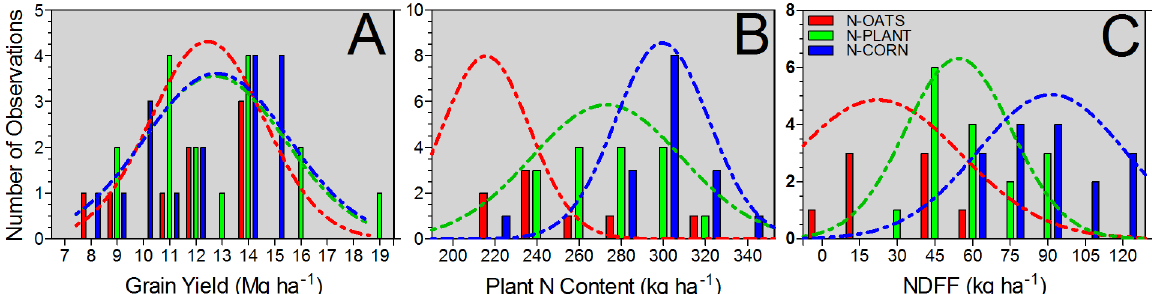
Fig 3. Data distribution for grain yield (A), plant N content (B) and NDFF (C) for the fertilizer N timing groups: fertilizer N applied to oats (N-OATS, red color), N applied at pre-plant and at planting time for corn (N-PLANT, green color), and in-season N added at V3 and at V3/V6 growth stages for corn (N-CORN, blue